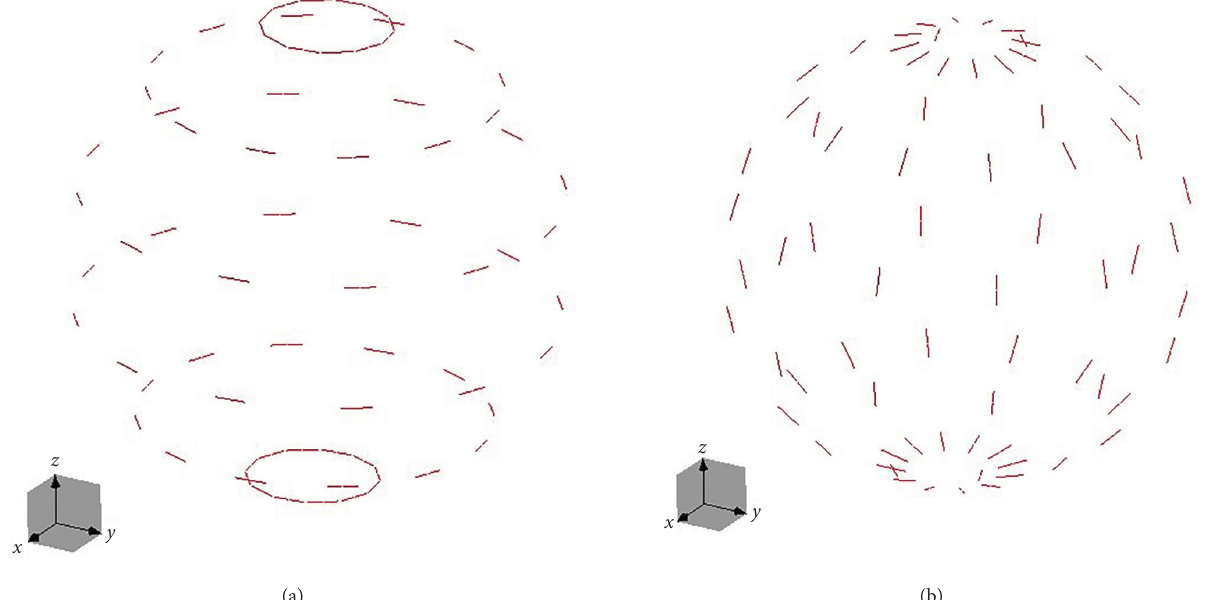
Figure 3: Antenna array configurations. (a) φ -Oriented dipoles and (b) θ -oriented dipoles.